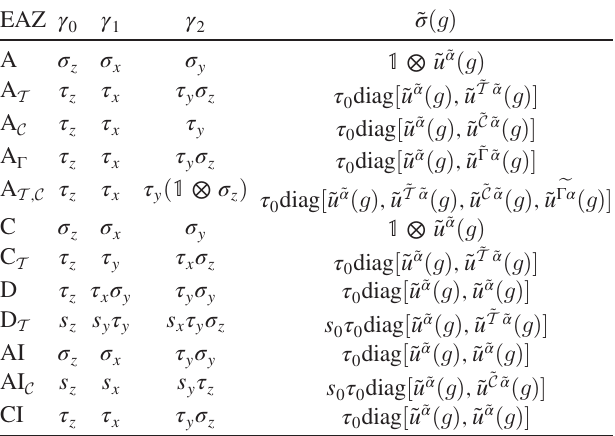
TABLE VIII. Gamma matrices in Eq. (50) and on-site unitary symmetries. Here, ˜ u ˜ α is an irreducible representation of the on- site unitary symmetry group labels of the time-reversal-, the particle-hole-, and the chiral- symmetry-related irreducible representations.